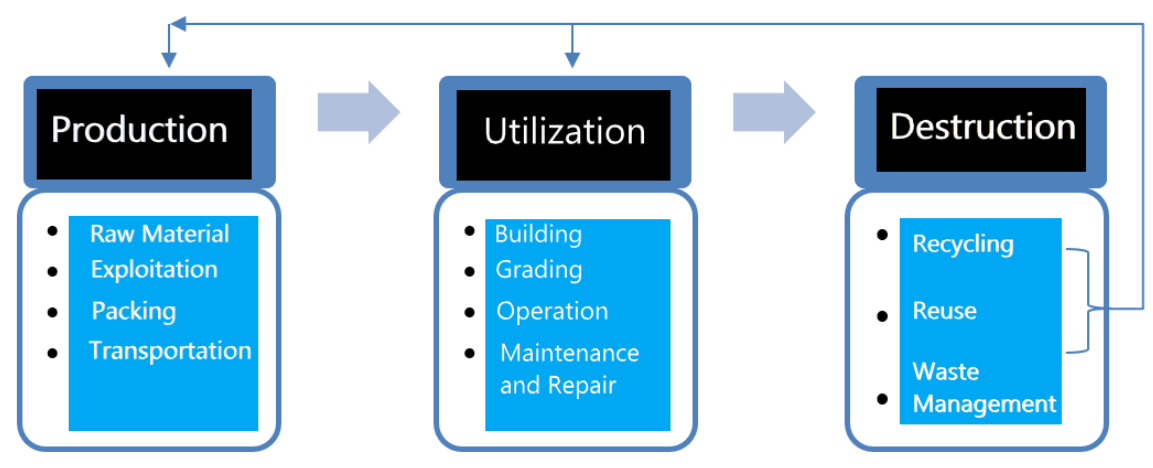
Figure 1. Life cycle stages for building and building materials [10]